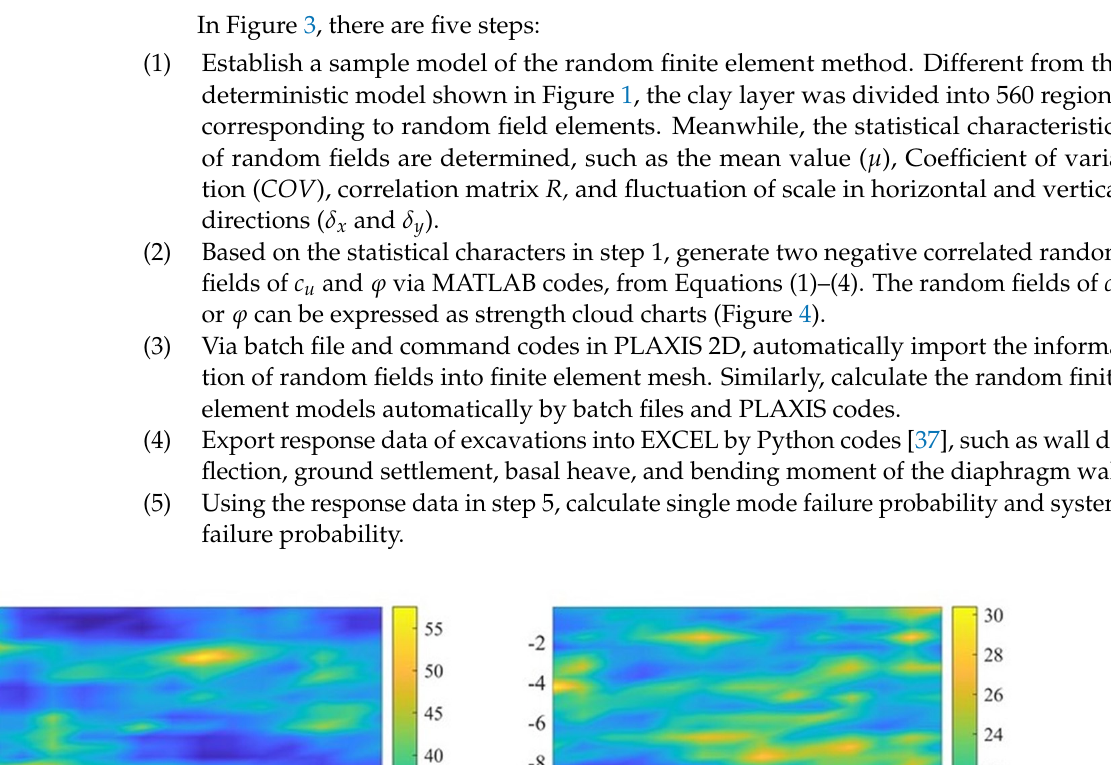
Figure 3. Flow chart of random finite element method.